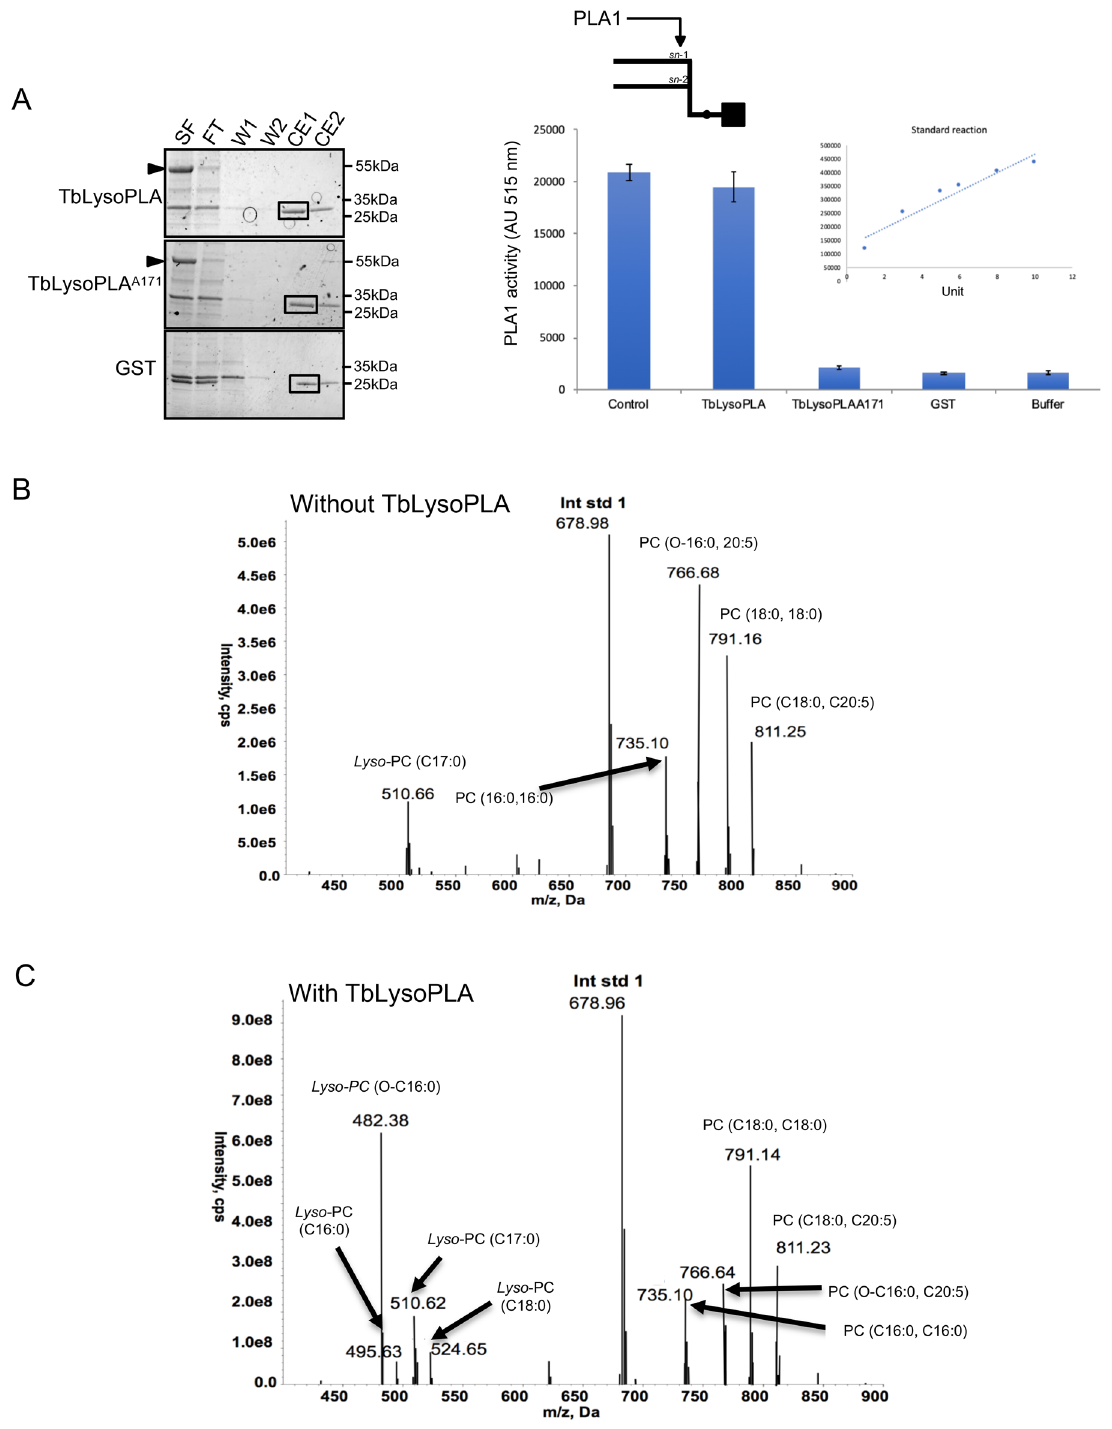
Figure 2. Lipolytic activity of recombinant TbLysoPLA. ( A ) PLA1 activity assay on recombinant proteins expressed in E. coli. Purification steps were analysed by coomassie gel (above gel). As examplified for TbLysoPLA, SF (Soluble Fraction), FT (Flow Through), W1-2 (Washes), CE1-2 (Clivage/Elution after thrombin release). Tested fractions were dialysed against PBS. PLA1 activity was measured using Enzcheck PLA1 assay (Molecular Probes). Control was a commercial phospholipase A1 (Sigma L3295). TbLysoPLA, full-length TbLysoPLA; TbLysoPLA SA171 , mutated TbLysoPLA where the putative active serine 171 was replaced by an alanine; GST, Glutathione-S-Transferase was eluted with 20 mM glutathione instead of thrombin cleavage. Supplemental information concerning expression and purification can be found on Fig. S2. ( B ) Substrate specificity of recombinant TbLysoPLA. TbLysoPLA was incubated ( B ) or not ( A ) with a Lipid Mix containing lyso -PC C17:0, PC (diC16:0), PC O-C16, 20:5, PC